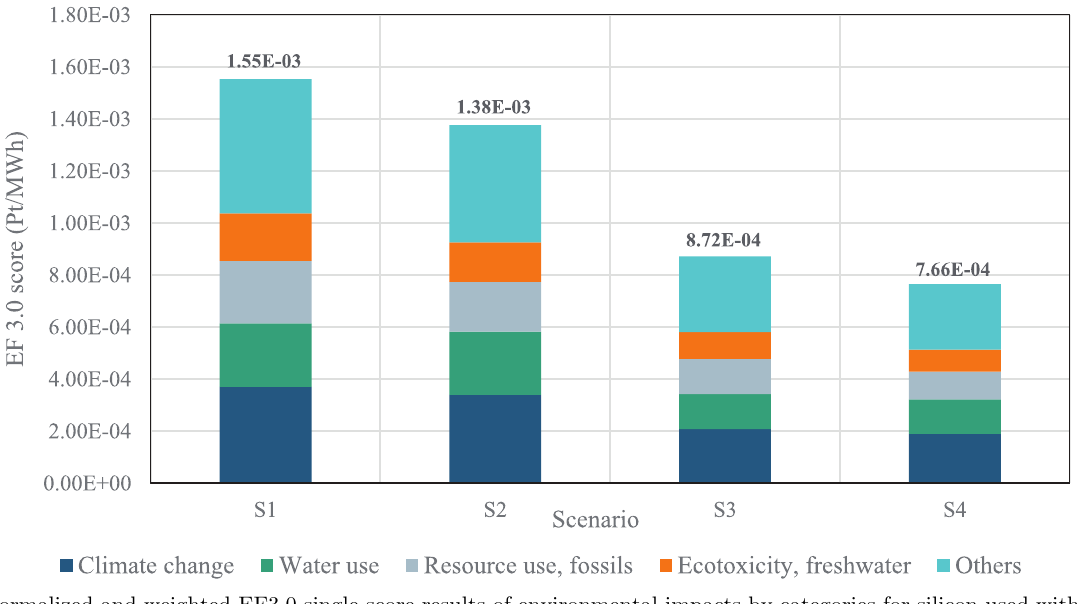
Fig. 3. Normalized and weighted EF3.0 single score results of environmental impacts by categories for silicon used within the PV module in scenarios 1 – 4.